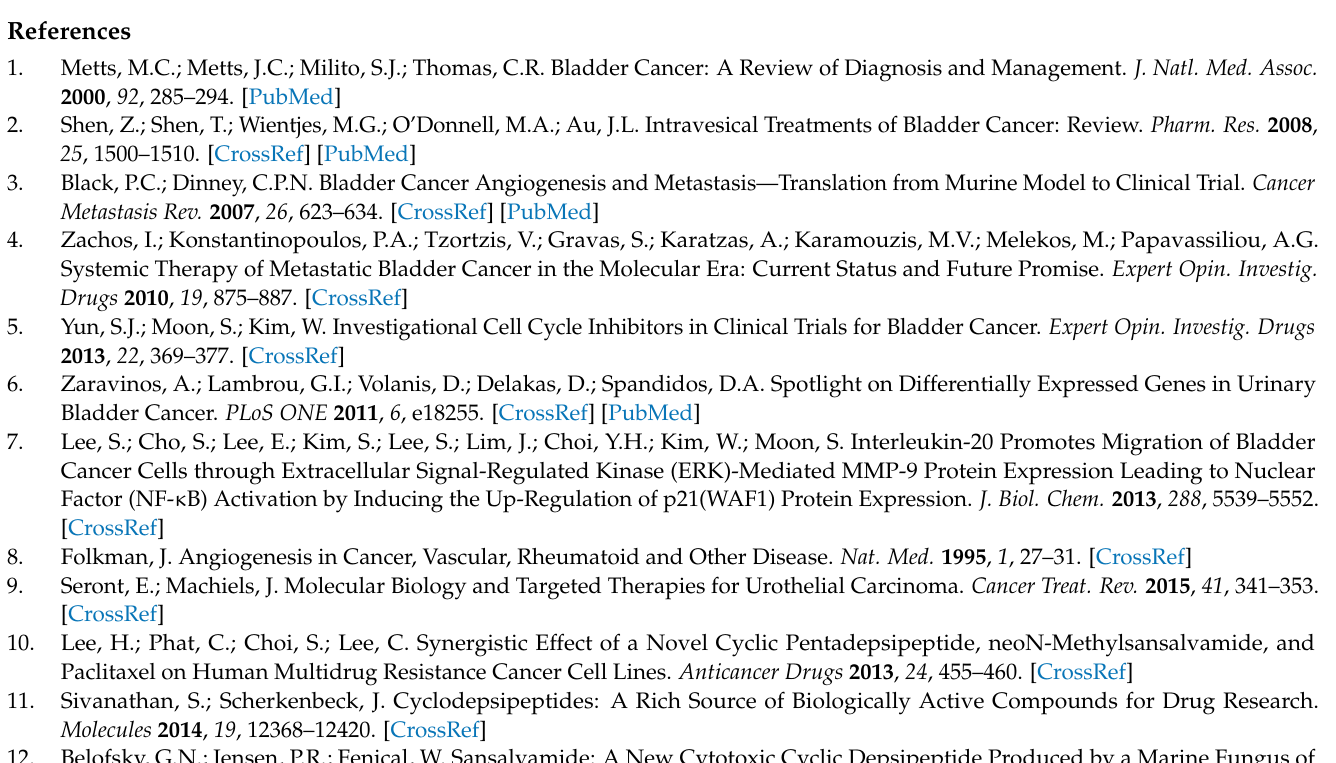
mice, Figure S3: Uncropped Western Blot Images for Figure 2D, Figure S4: Uncropped Western Blot Images for Figure 2E, Figure S5: Uncropped Western Blot Images for Figure 3A, Figure S6: Uncropped Western Blot Images for Figure 3B, Figure S7: Uncropped Western Blot Images for Figure 5B, Figure S8: Uncropped Western Blot Images for Figure 5C, Figure S9: Uncropped Western Blot Images for Figure 7B, Table S1: 1H (400 MHz) and 13C (100 MHz) NMR data for N-methylsansalvamide in pyridine-d5, Table S2: Assessment of acute toxicity on oral consumption of NMSSA in male and female